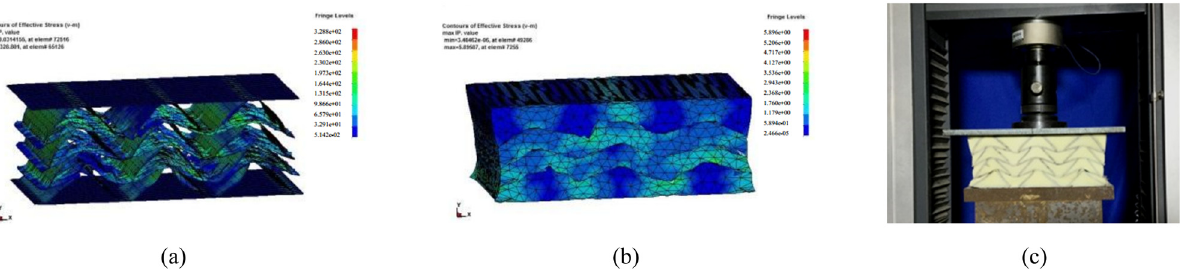
Figure 13: Strain and stress of specimen TS - T - A45: ( a ) GFRP, ( b ) PU foam, ( c ) quasi - static experiment.